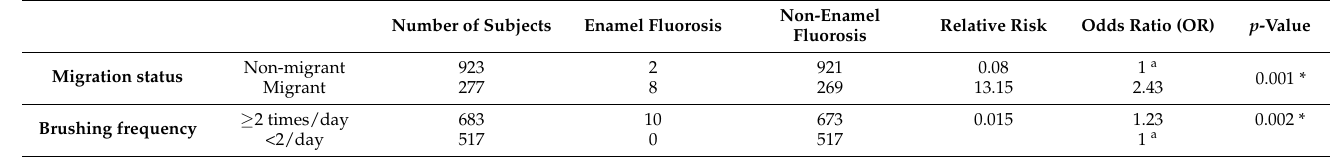
Table 3. Regression analysis to predict the outcome dental fluorosis in primary dentition. Number of Subjects Enamel Fluorosis